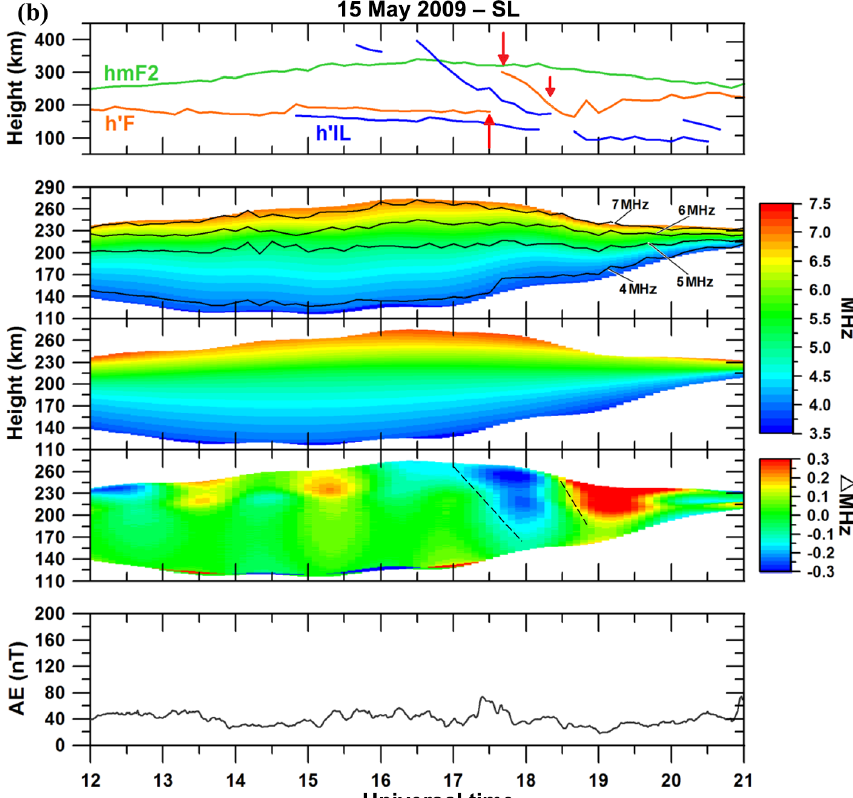
Figure 10. (a) Sequence of ionograms during 15:30–18:20UT on 15 May 2009 showing the perturbation in the F2 layer trace that reached low altitudes and evolved to a descending intermediate layer over São Luís. The blue arrow indicates the downward movement of perturbation in F layer and the purple arrow indicates the presence of another IL occurring simultaneously. (b) In the first panel the virtual height of the F layer h (cid:48) F (orange line), the F2 layer peak hmF2 (green line) and the virtual height of ILs ( h (cid:48) IL, blue line) are shown. The red arrows indicate some modifications in the F layer in the form of the formation of the IL from a detachment of the F1 layer and the junction of the IL with the F1 layer. From the second to the fourth panels the variation of plasma frequency as a function of universal time and altitude without the high frequency (periodicities higher than 1.75h) is shown, the reconstructed signal containing only periodicities higher than 6h and the difference between the aforementioned profiles, respectively. The downward phase propagation in the residual (cid:49) MHz is indicated by the dashed gray line. The last panel shows the auroral